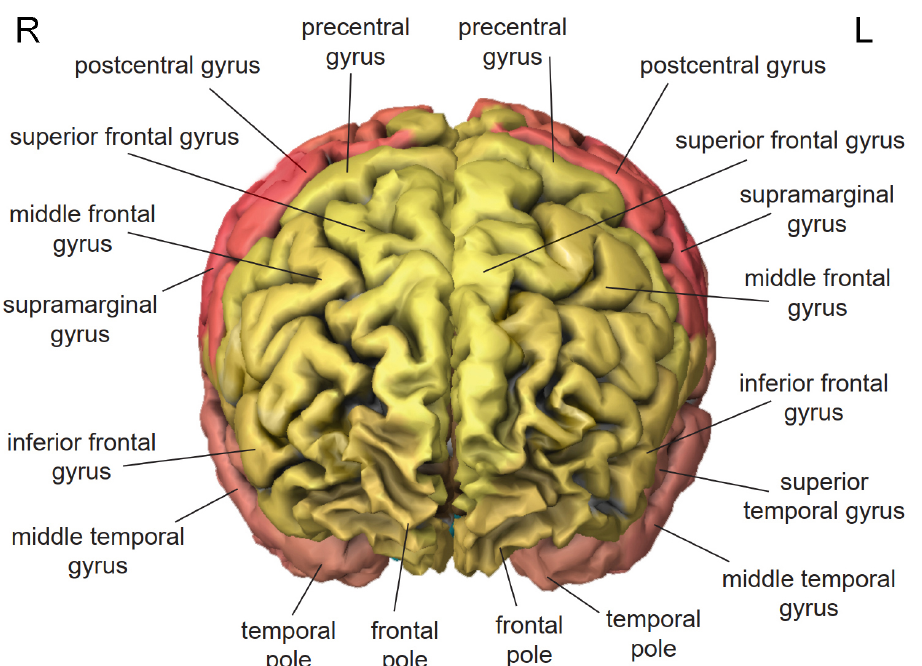
Figure 1. Frontal view of the human brain based on H0351.2002 dataset in Allen Brain Atlas. Frontal lobe (yellow), parietal lobe (red), temporal lobe (pink). L, left; R, right.